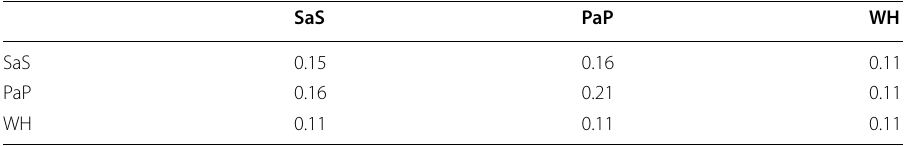
Table 4 Sqrt-cosine similarity scores among